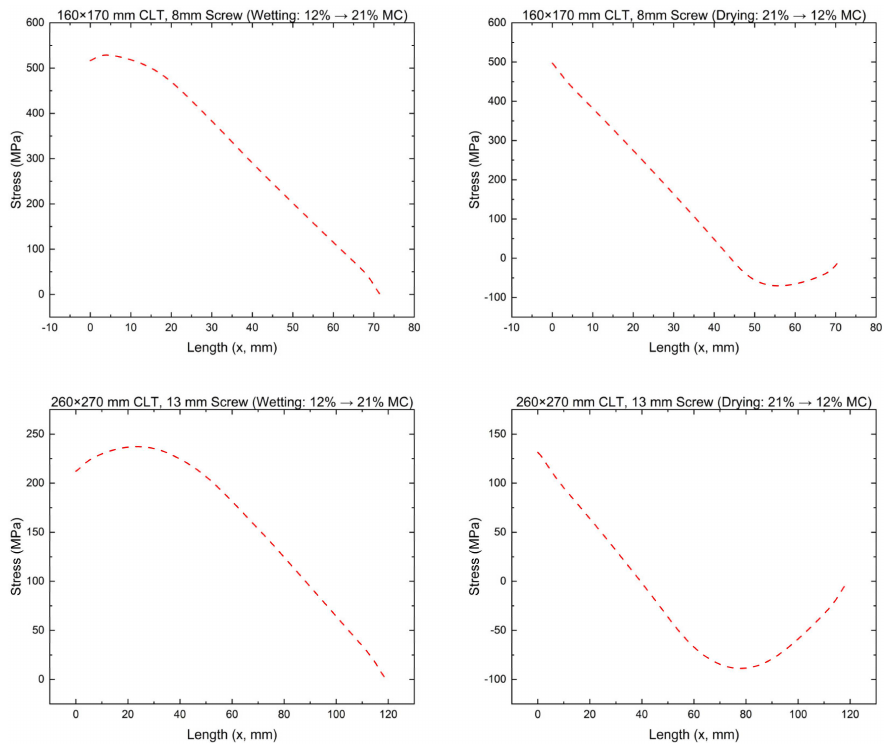
Figure 18. Screw axial stress distribution in CLT.